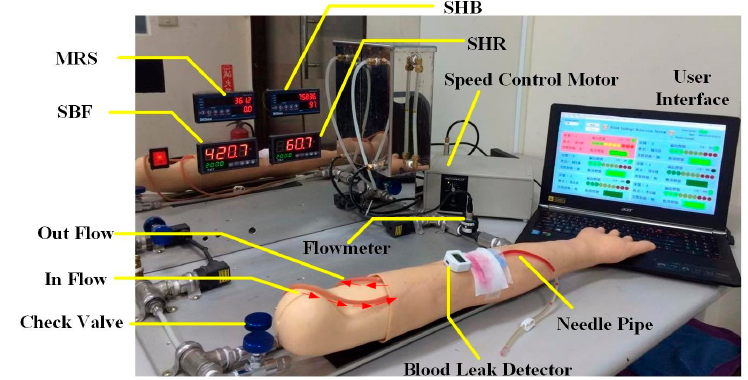
Figure 8. Blood circulation simulation system.